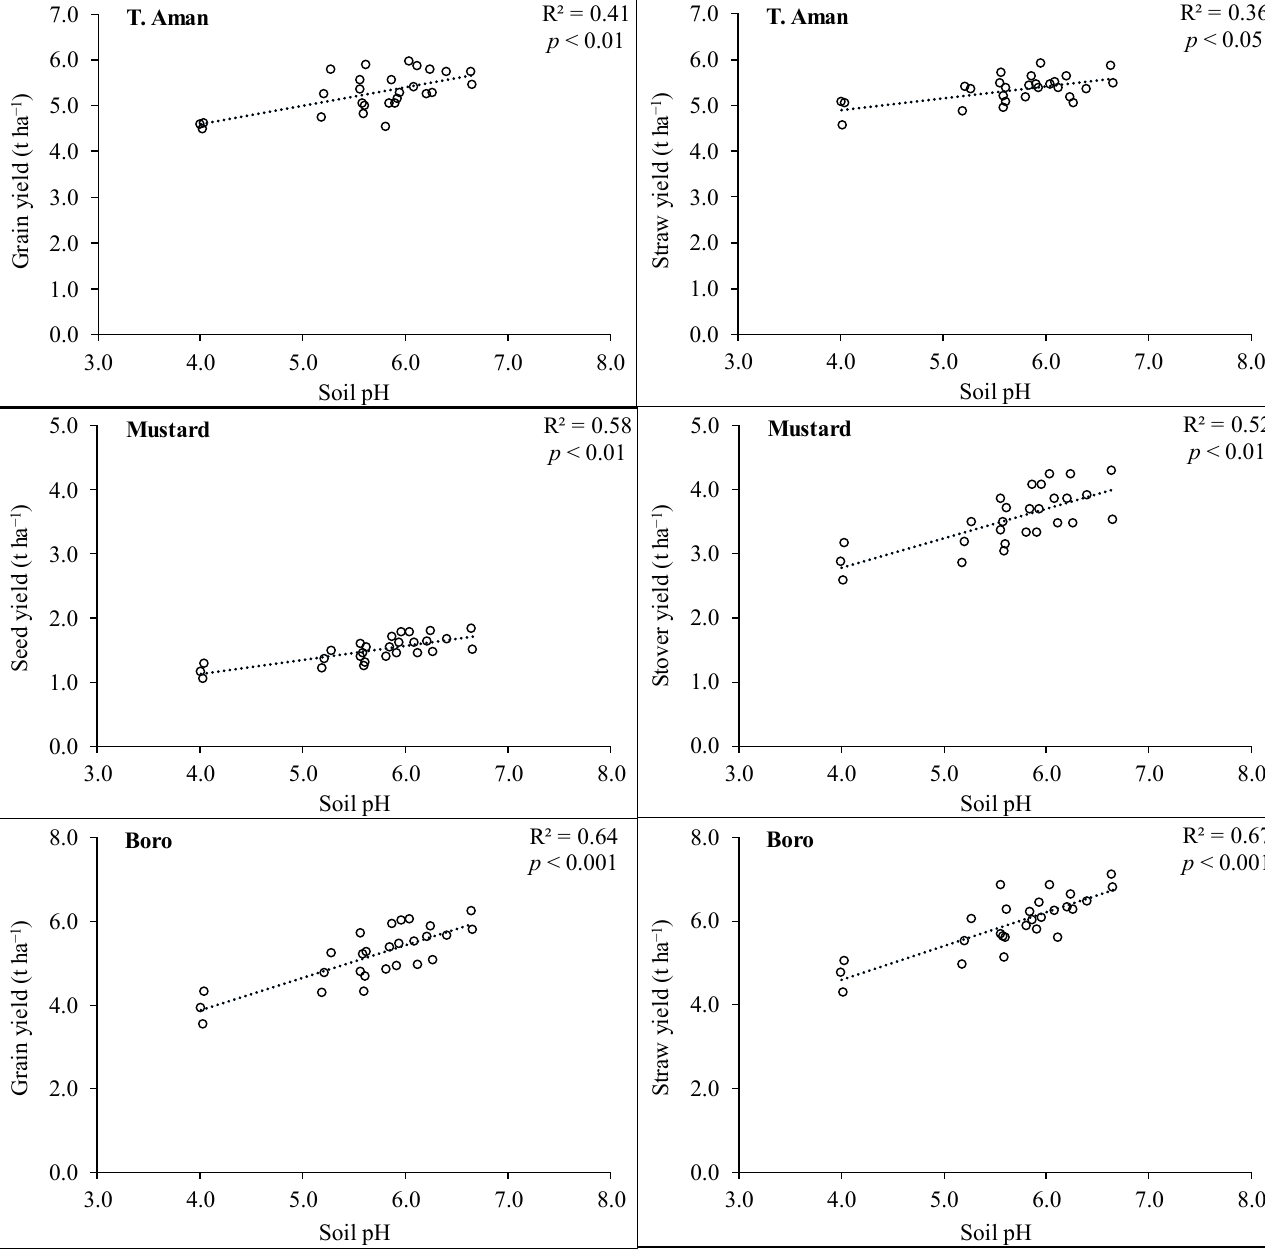
Figure 1. Relationship between soil pH and crop yield in T. Aman–Mustard–Boro cropping pattern as influenced by lime and manure amendment. Empty circle in the figure indicates the correlation point between yield and soil pH.